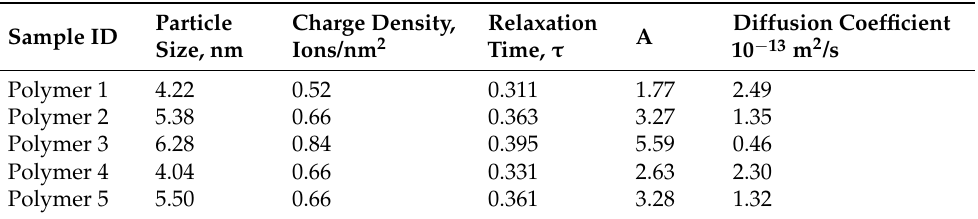
Table 6. Particle size, charge density, relaxation time and diffusion coefficient of CUP polymers 1–5, measured at the average concentration of 1.03 ± 0.02 mol/m 3 .